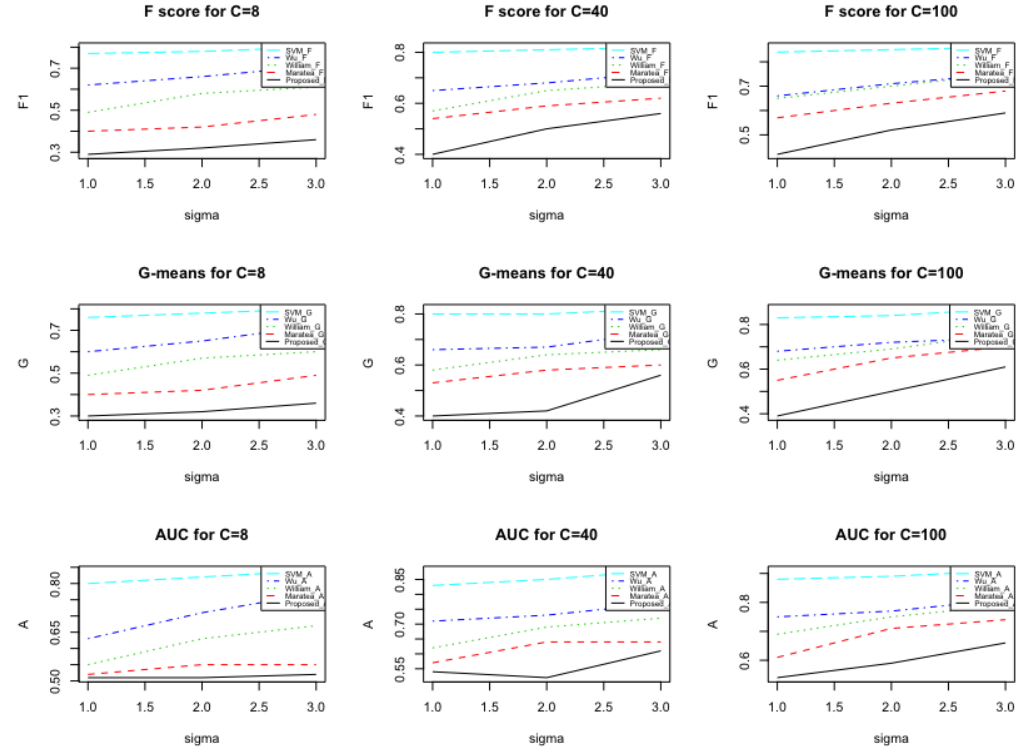
Figure 2. Performance of the competitor methods for Scenario 2.